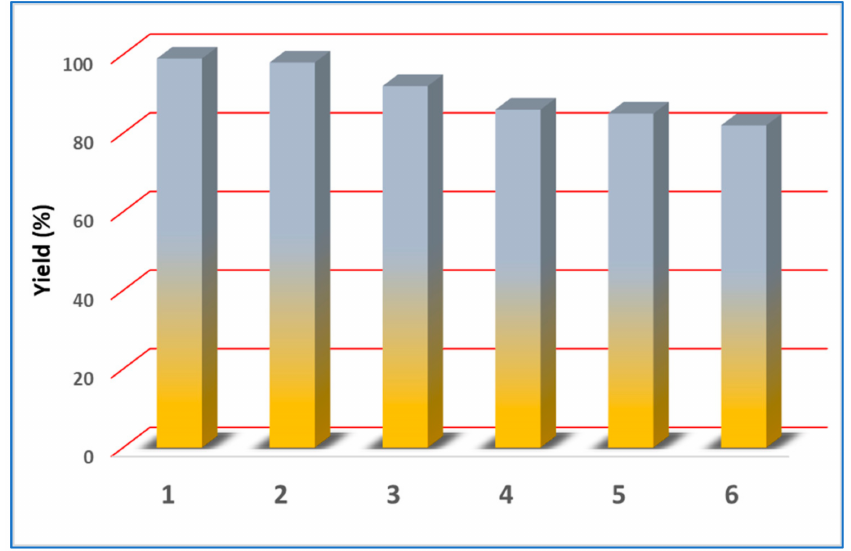
Figure 4. Yield of 2-benzylidenemalononitrile ( D ) upon catalyst recycling for the deacetalization– Knoevenagel reactions catalyzed by CP 1